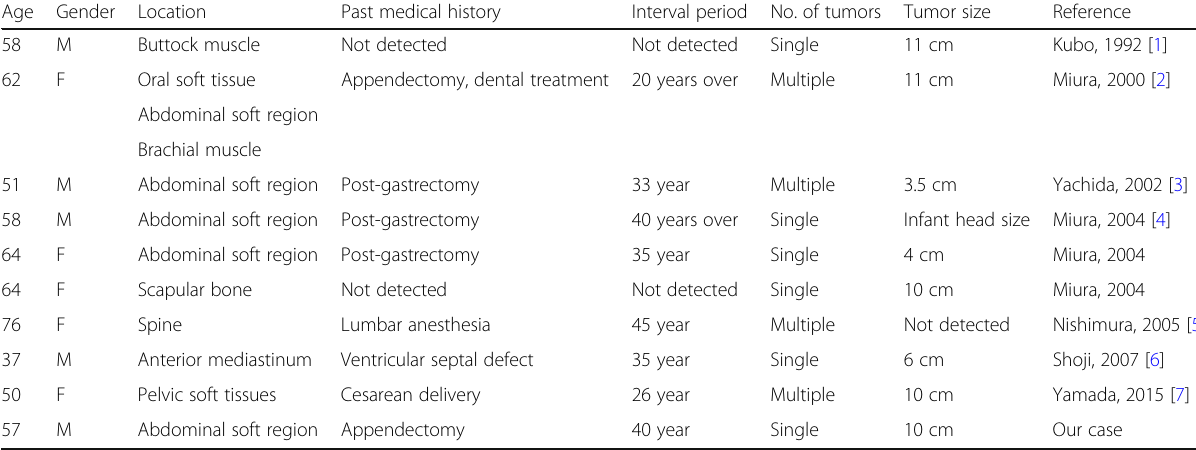
Table 1 Clinical summary of phosphoglyceride crystal deposition disease Age Gender Location Past medical history Interval period No. of tumors Tumor size